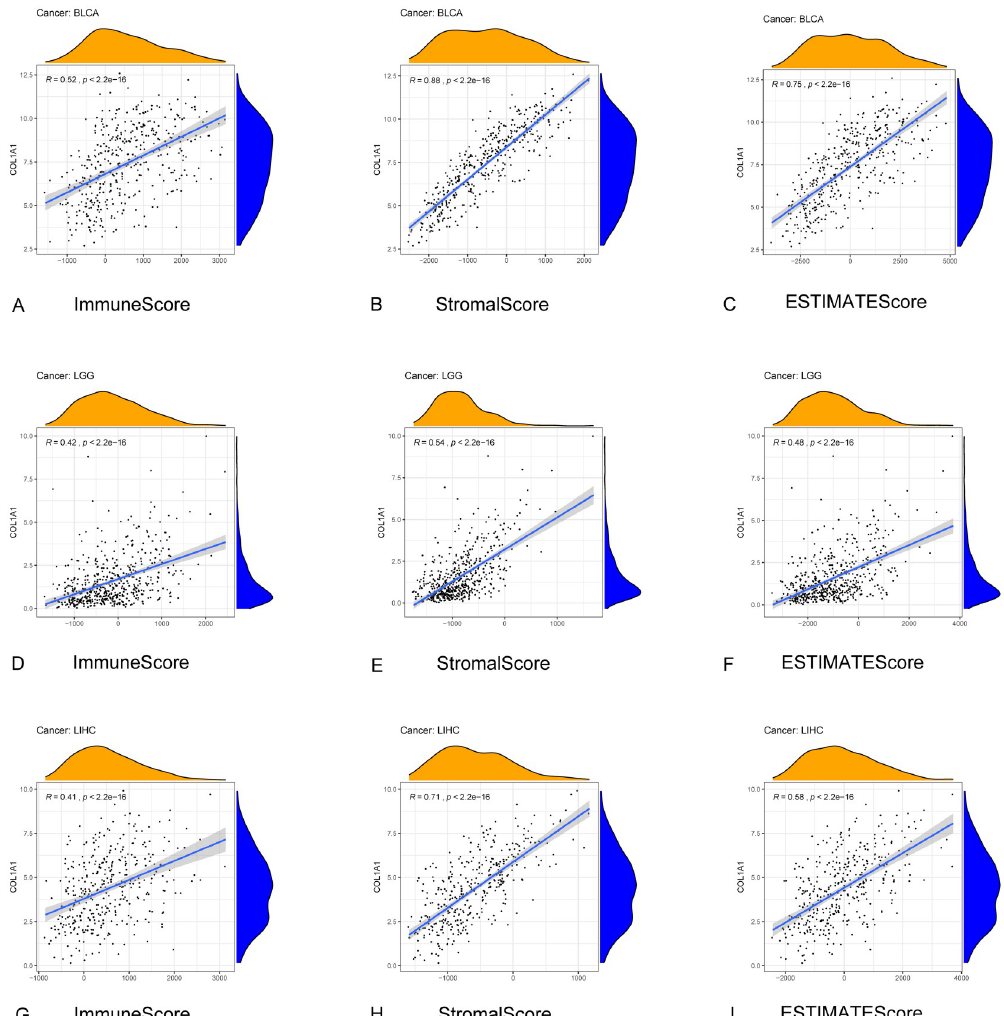
Fig 6. Correlation between COL1A1 expression and TME in diffrent tumer. (A-C). Relationship between COL1A1 expression and Stromal Score, Immune Score and ESTIMATE Score in BLCA. (D-F). Correlation between COL1A1 expression and Stromal Score, Immune Score and ESTIMATE Score in LGG. (G-I). Relationship between COL1A1 expression and TME in LIHC. https://doi.org/10.1371/journal.pone.0269533.g006 cells, monocytes, TAMs, M1 and M2 macrophages, neutrophils, NK cells, DCs, Th1 cells, Th2 cells, Tfh cells, Th17 cells, Tregs and exhausted T cells. According to the results adjusted for purity, the expression level of COL1A1 in LGG was significantly correlated with most of the immune cell marker sets (Table 3). However, expression of COL1A1 was significantly corre- lated with only 9 immune cell marker sets in MESO. Specifically, the results show that COL1A1 is significant correlated with CD8A, CD8B of CD8+ T cell markers, CD3D, CD3E, CD2 of T cell markers, CD19, CD79A of B cell markers, CD86, CD115 of monocyte markers, CCL2, CD68, IL10 of TAM markers, IRF5, COX2 of M1 macrophages markers, CD163, VSIG4, MS4A4A of M2 macrophage markers, CD11b, CCR7 of neutrophils markers, KIR2DL1, KIR2DL3, KIR2DL4, KIR3DL1, KIR3DL2, KIR2DS4 of natural killer cell markers, HLA-DPB1, HLA-DQB1, HLA-DRA, HLA-DPA1, BDCA-1, BDCA-4, CD11c of DCs mark- ers, T-bet, STAT1, IFN- γ of Th1 markers, GATA3, STAT6, STAT5A of Th2 markers, STAT3